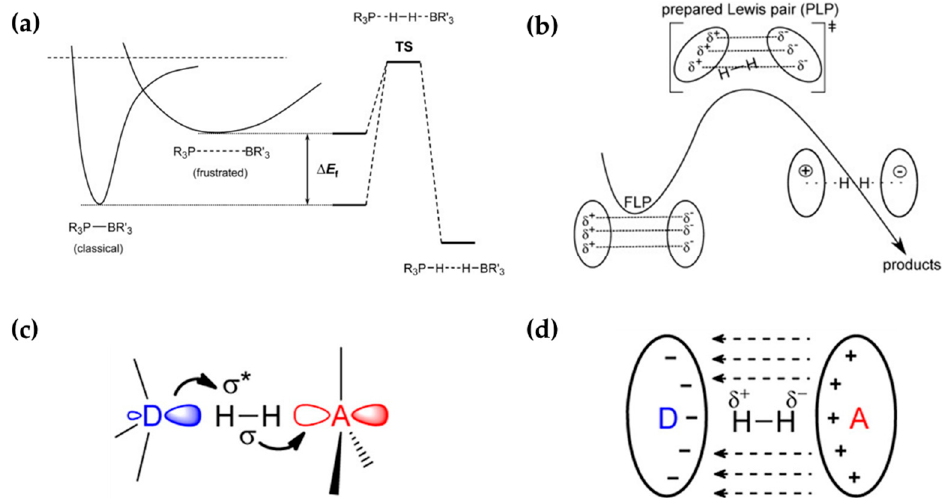
Figure 2. Role of ( a ) frustration and ( b ) electron field in mechanisms of H 2 activation catalyzed by FLPs proposed by Rokob et al. and Grimme et al., respectively. Schemes of FLP-catalyzed H 2 dissociation via ( c ) the ET mechanism (symbol * indicates antibonding orbital) and ( d ) the EF mechanism. ( a ), ( b ), and ( c , d ) are from references [62–64] respectively, with permission from John Wiley and Sons and American Chemical Society.